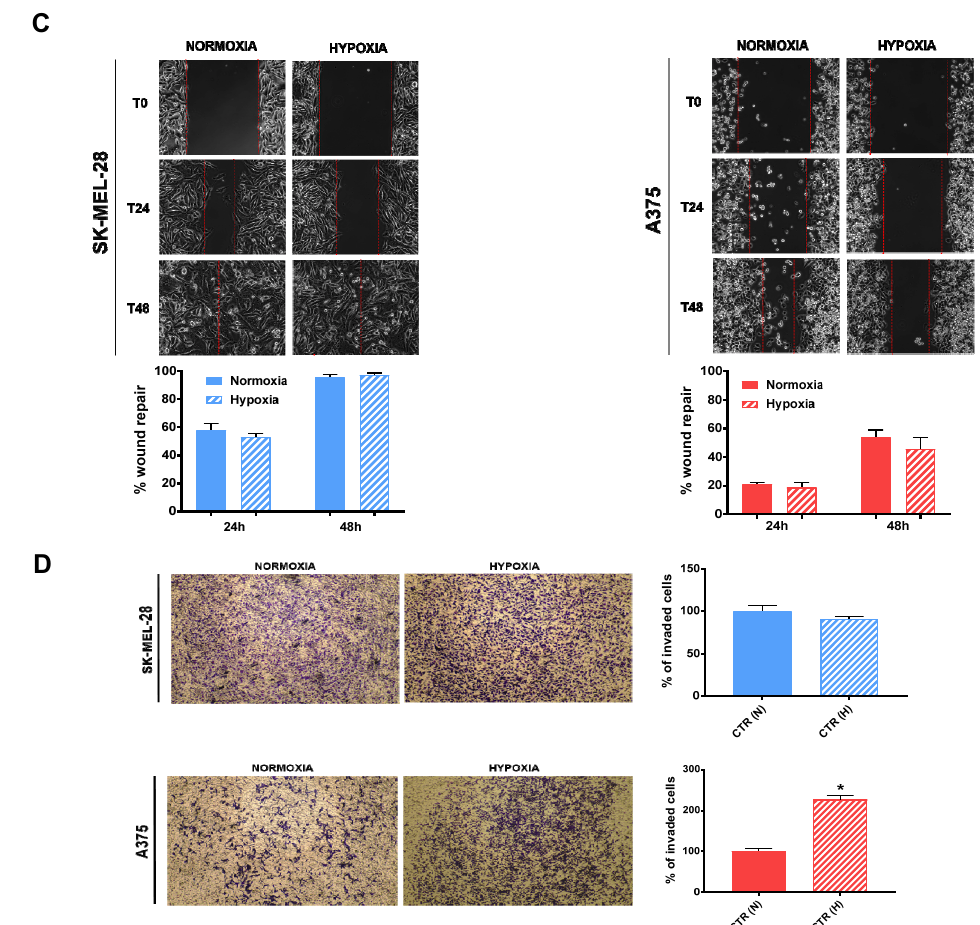
Figure 1. Effects of hypoxia on SK-MEL-28 and A375 cell lines. ( A ) HIF-1 α ; ( B ) GLI1, SMO, and CAXII western blot; ( C ) cell migration by wound-healing assay; ( D ) cell invasion by modified Boyden chamber, under normoxic (N) or hypoxic (H) conditions. β -actin was used as loading control for western blot. Blots and pictures are representative of three independent experiments. Means ± SEM are presented. (n = 3; * p ≤ 0.05 and ** p ≤ 0.01 indicate statistically significant